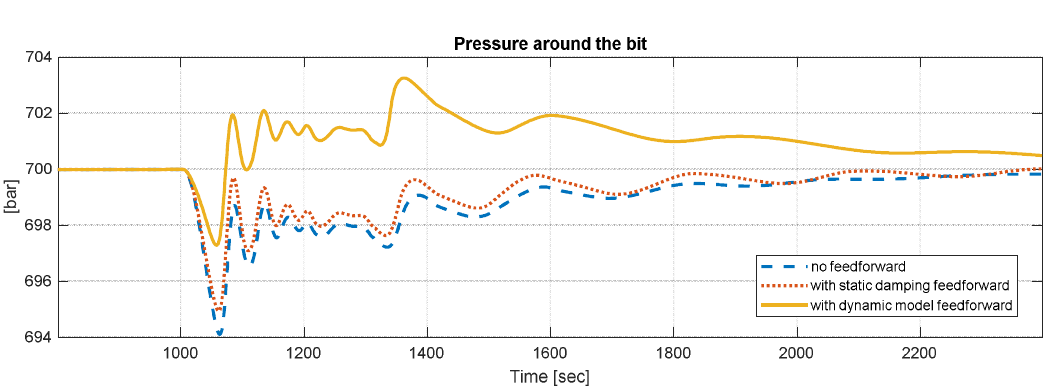
Figure 12: Pressure response with no feedforward and with feedforward (using robust controller parameters and subject to 7 sec measurement delays and 3 sec sampling